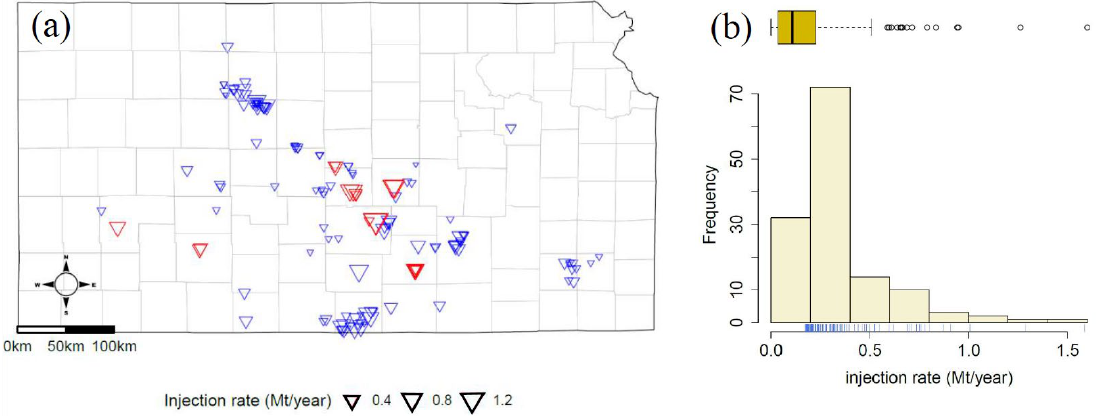
Figure 1. ( a ) Wells injecting more than 0.17 Mt/year of waste fluid into the Arbuckle aquifer across Kansas. The red triangles show Class I and the blue triangles show Class II injection wells. ( b ) Histogram of injection rates for the wells injecting >0.17 Mt/years waste-fluid across Kansas (circles indicate outliers).